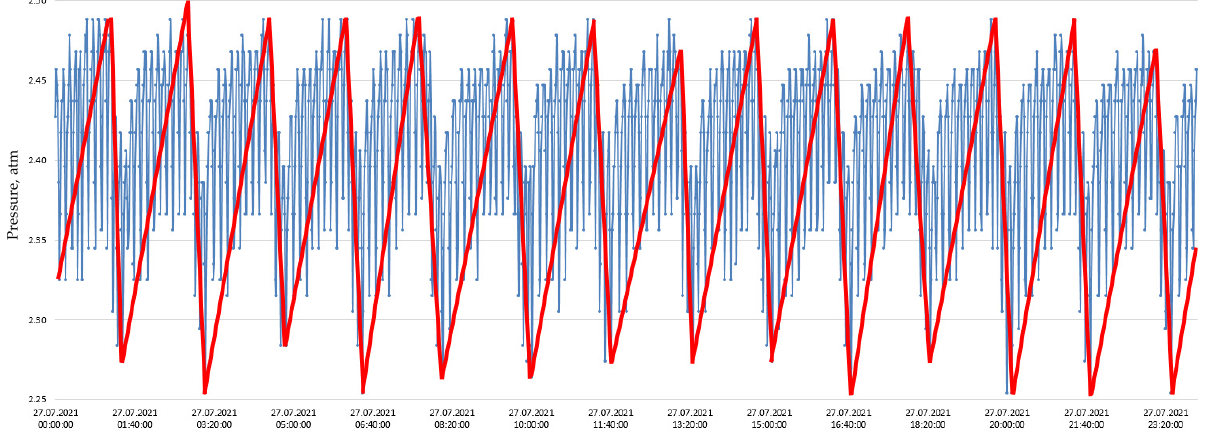
Figure 11. Harmonic of the KOGS No.110. The blue lines indicate the bottom hole pressure, the red lines - harmonic of the KOGS operation (the upper peak – the KOGS is waiting for gas collection in the wellbore space, the lower peak – the KOGS starts to work with gas pumping 4.